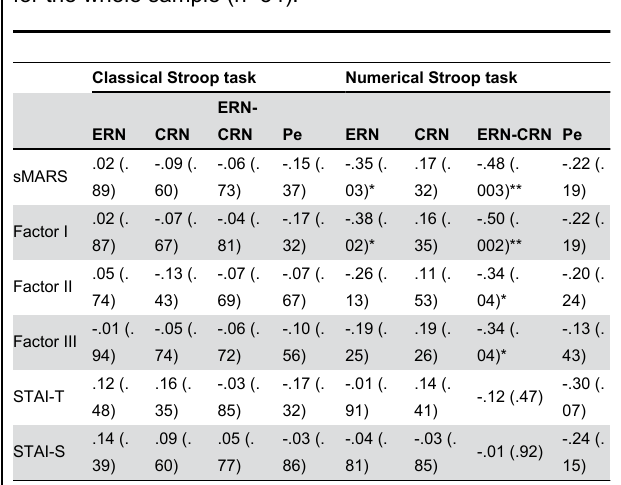
Table 4. Brodmann areas of statistically stronger cerebral activation Lobe Structure Classical